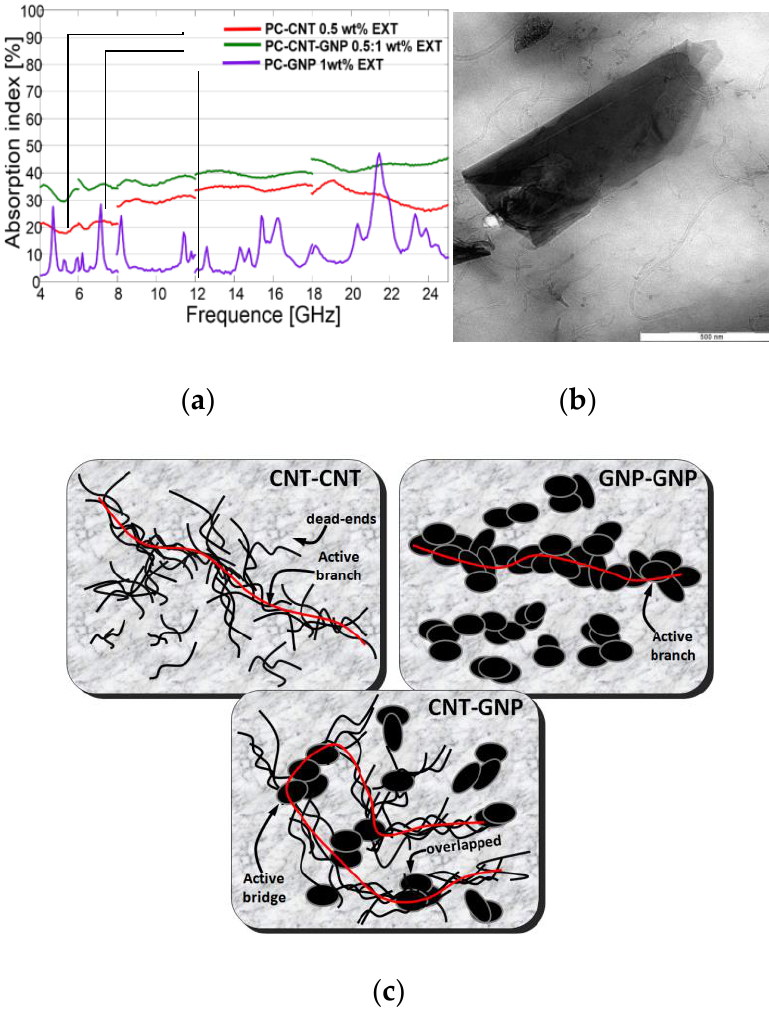
Figure 16. ( a ) Improvement of absorption performance by using a mixture of MWCNTs and GNPs ( b ) TEM micrograph of PC containing MWCNTs-GNPs 0.5: 1% (% w/w) ( c ) Schematic illustration of interconnected conductive nanofillers network formation of CNT and/or GNPs in the polymer nanocomposite (adapted from